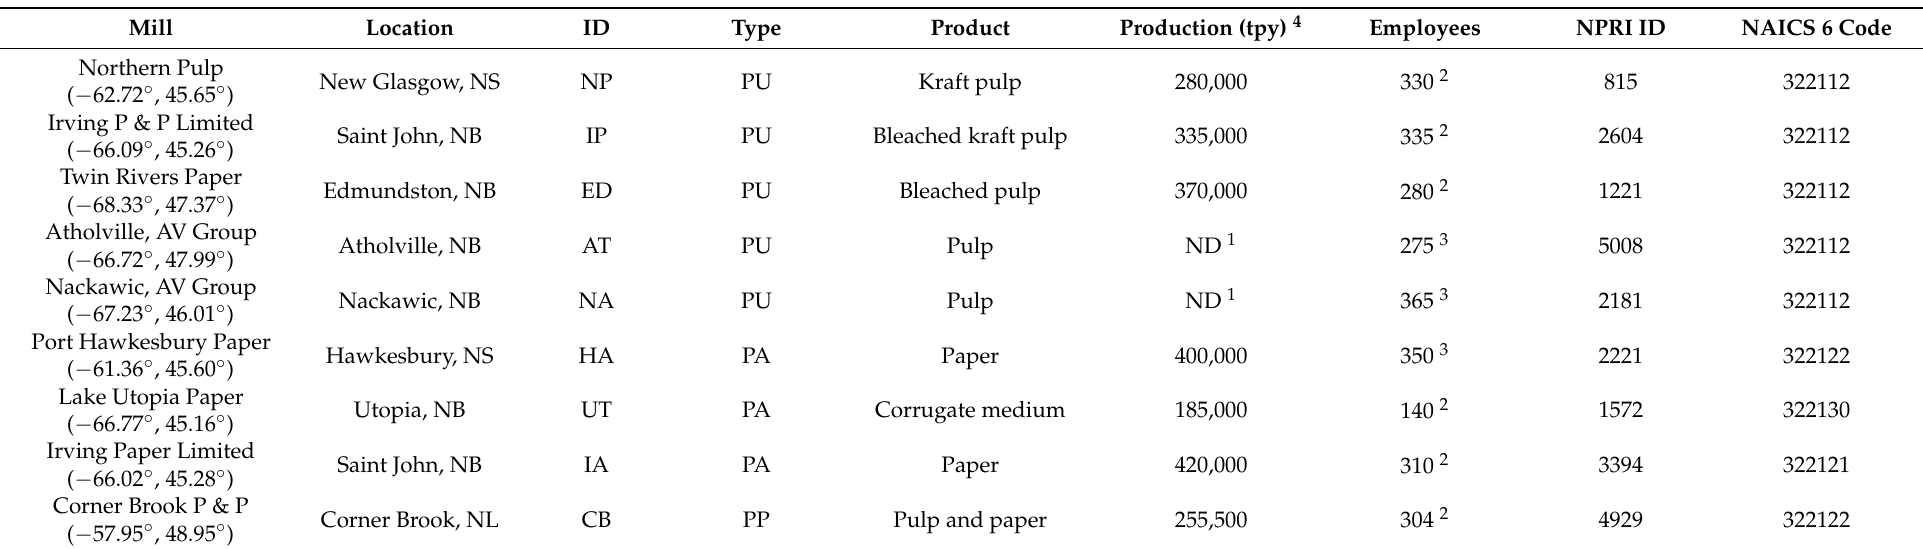
Table 2. Location of Atlantic Canadian pulp and/or paper mills and their characteristics. PA: Paper; PU: Pulp; PP: Pulp and